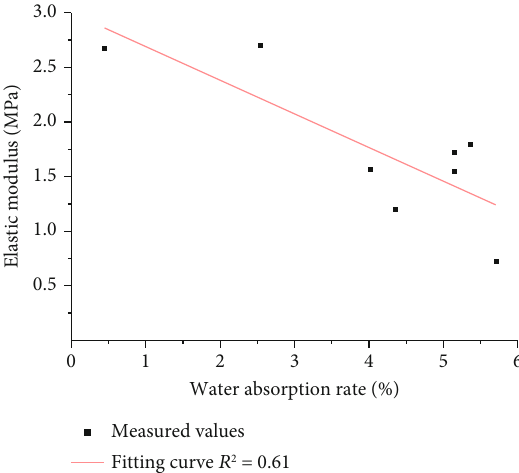
Figure 26: Relationship between the elastic modulus and water absorption of